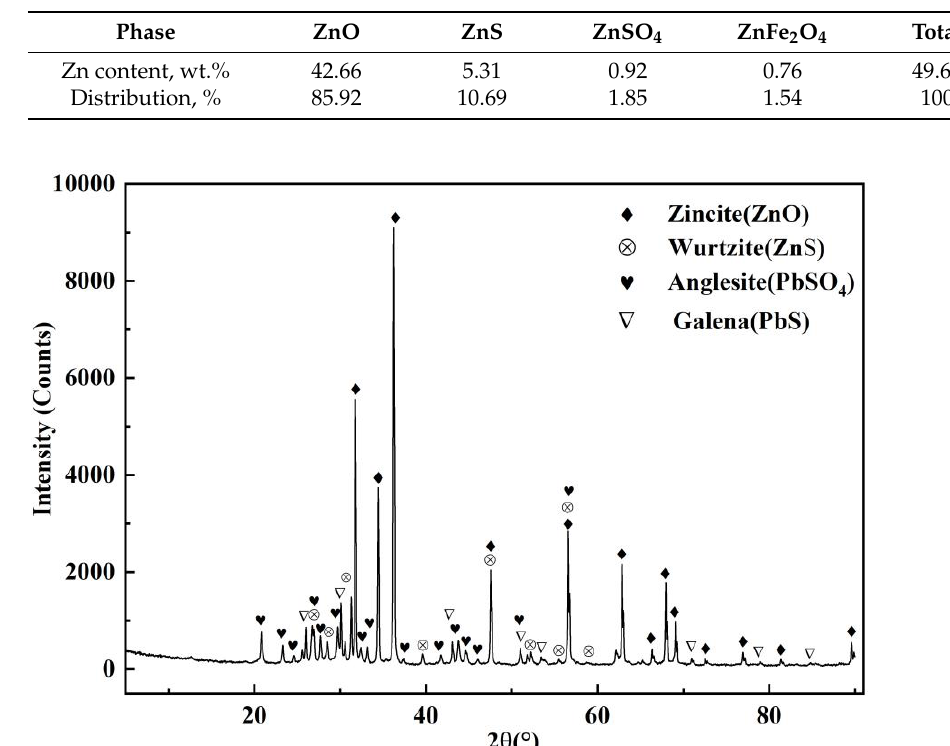
Figure 2. XRD pattern of characterization of the GCR.